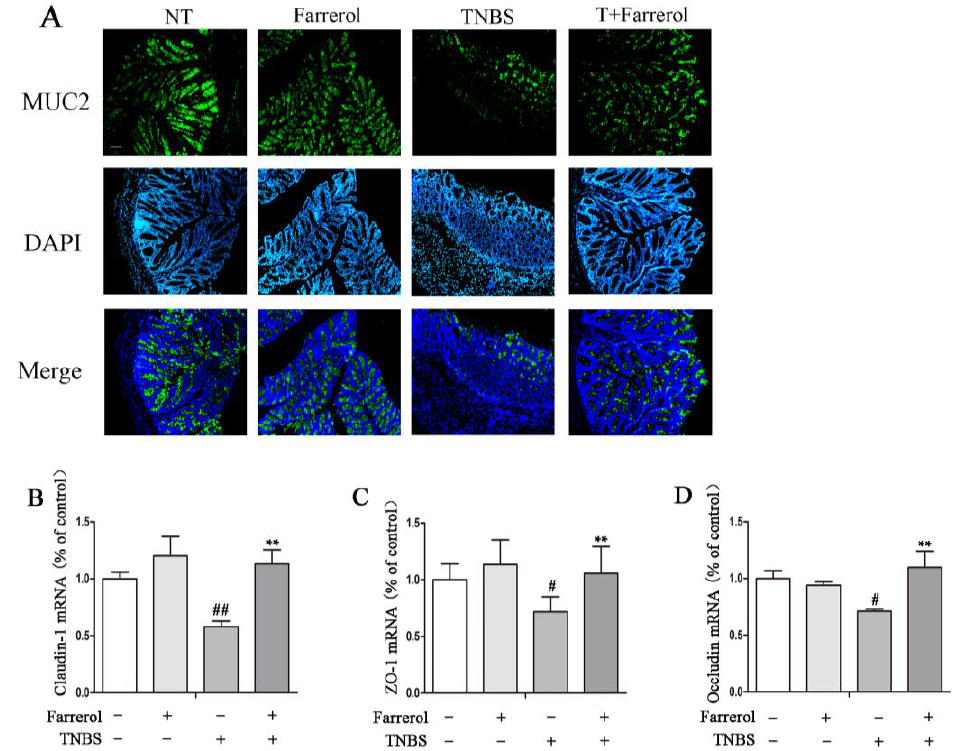
Figure 3. Farrerol maintains mucin-2 (MUC2) expression and proper tight junctions in TNBS-induced mice. ( A ) Colonic MUC2 immunofluorescence staining. The MUC2 was observed by epifluorescence microscope. Green represented MUC2, and Blue represented DAPI. The magnification is 10 × , and the scale bar represents is 100 µ m. The gene expression of tight junction proteins including claudin-1 ( B ), ZO-1 ( C ), and Occludin ( D ) in the colonic tissue. n = 10, # p < 0.05 and ## p < 0.01 compared to the control group, ** p < 0.01 compared to the TNBS treatment group, and statistical significance was determined by ANOVA.